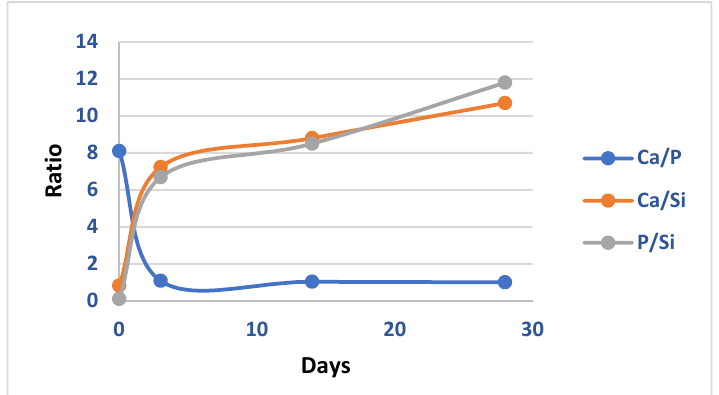
Figure 5. Ca/P, Ca/Si, P/Si ratios at different time of SBF soaking (0, 3, 14 and 28 days) evaluated by XPS analysis.